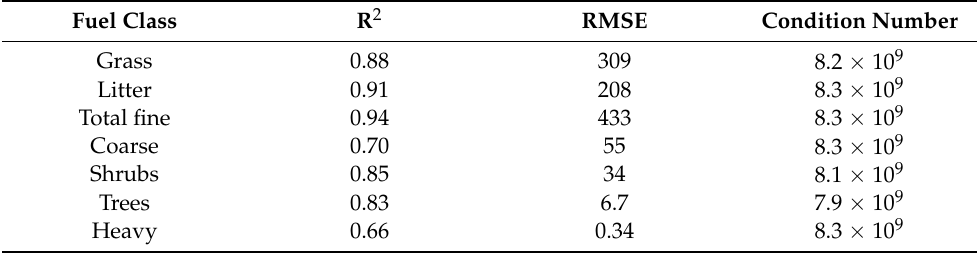
Table A2. Model train